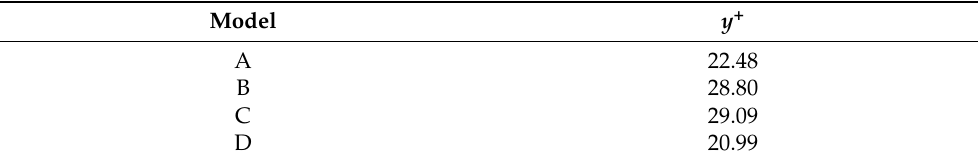
Table 4. Area-weighted average y + value obtained for each cyclone model.